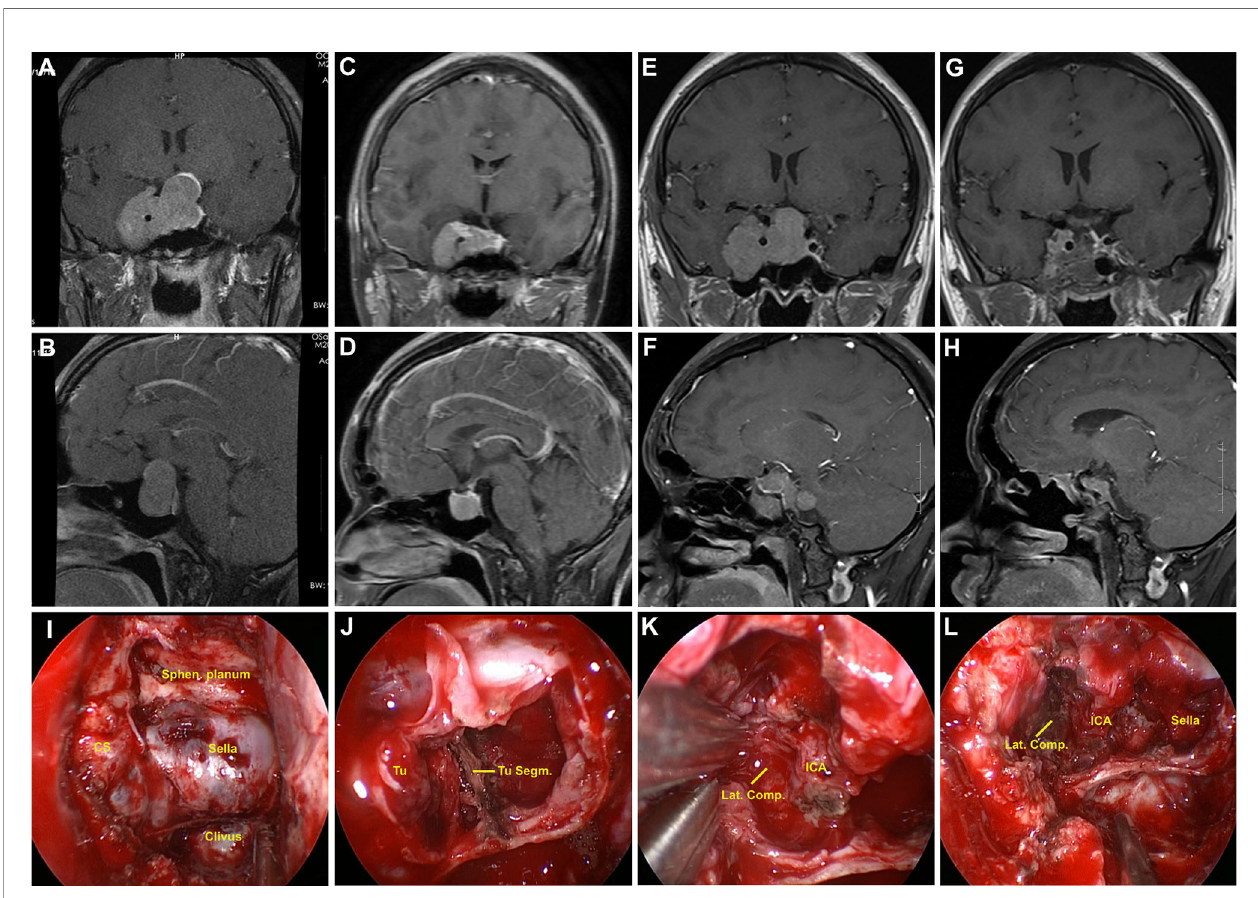
FIGURE 2 | Illustrative case of a residual GH-secreting PA after prior transcranial surgery. (A, B) Preoperative coronal and sagittal post-contrast MR images showing a giant PA (Knosp grade 4), with the mass extending to the suprasellar area and cavernous sinus; moreover, cavernous segment of internal carotid artery (ICA) was totally encased by the tumor. (C, D) The patient had undergone transcranial surgery at another hospital. Early postoperative follow-up MR images revealed partial tumor removal. (E, F) Post-contrast T1-weighted MR images acquired one year after initial surgery showed residual tumor regrowth. (G – H) Postoperative MR images revealed near-total tumor removal. A small tumor piece was present at superior lateral compartment (Lat. Comp.)of cavernous sinus owing to adhesion. (I – L) Intraoperative photographs during repeat transsphenoidal surgery. (I) Sella and right cavernous sinus were widely exposed. (J) After debulking, tumor segmentation (Tu. Segm.) was observed. (K) Tumor in the right cavernous sinus presented fi brous and rubbery texture, and was sharply dissected from ICA. (L) Cavernous segment of ICA was observed after tumor removal. Sphen,